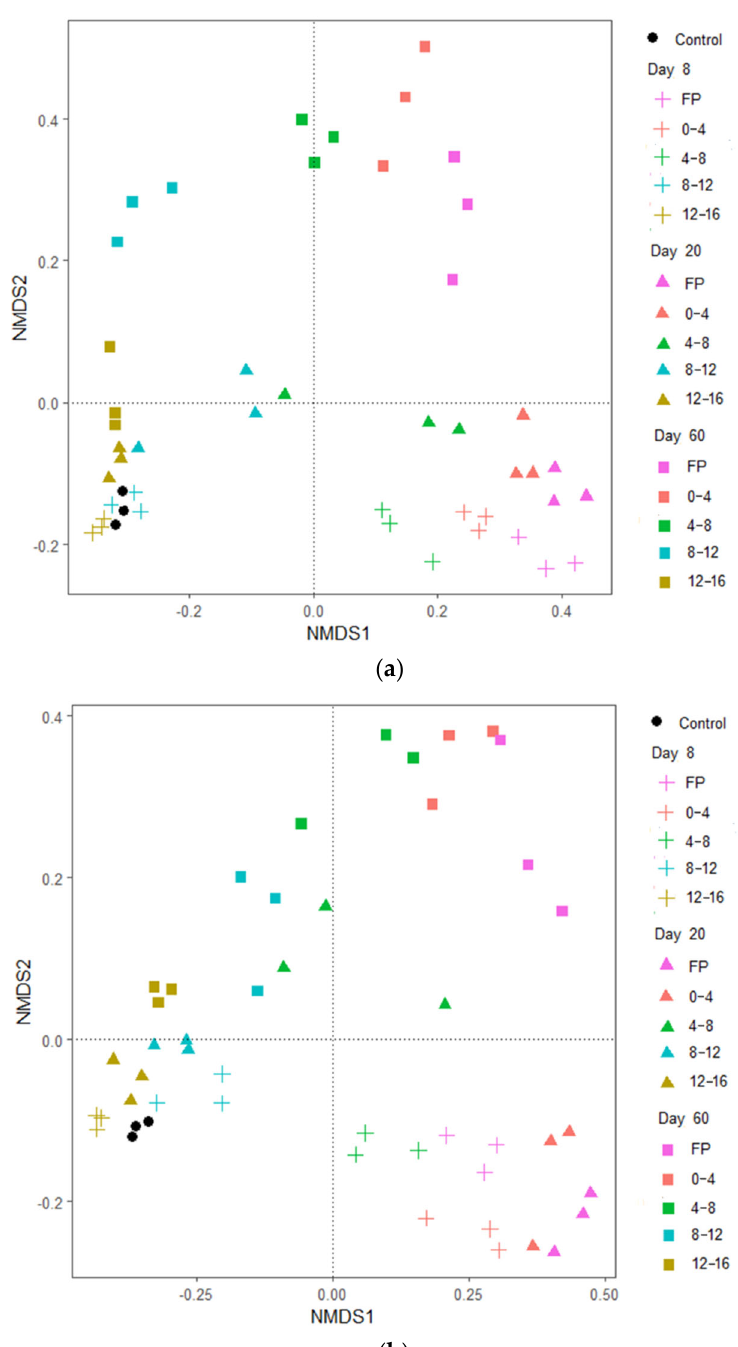
Figure 6. Non ‐ metric multidimensional scaling (NMDS) analysis based on Bray–Curtis dissimilar ‐ ity display differences in the bacterial community compositions for Qidong (( a ) QD) and Dangtu (( b ) DT). The shape symbols represent the samples under incubation times. Control: samples at Day 0 (pre ‐ culture and pre ‐ incubation). Day 8: samples at 8 days after urea application. Day 20: samples at 20 days after urea application. Day 60: samples at 60 days after urea application.